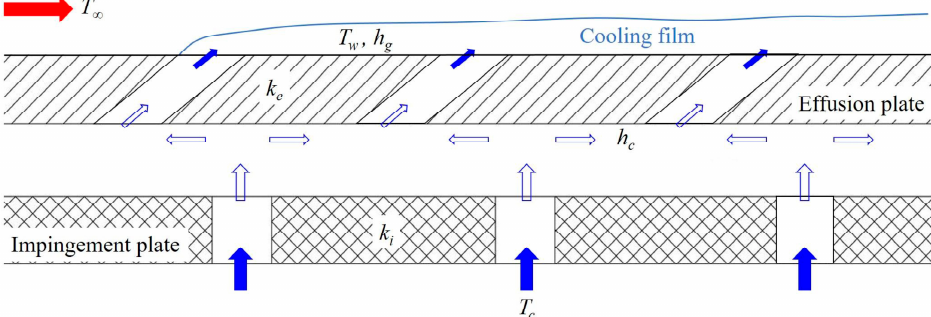
Figure 15. Schematic diagram of double-wall cooling principle.